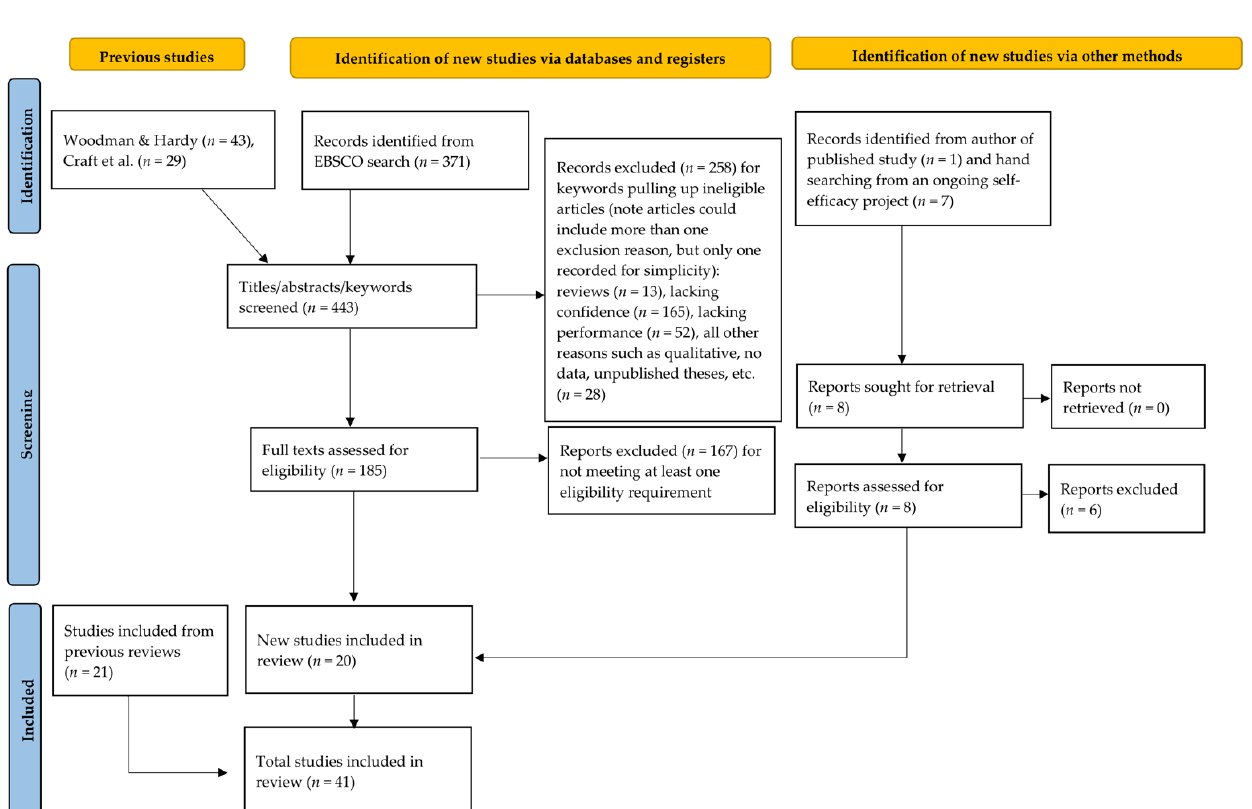
Figure 1. PRISMA flow chart for the identification of the included studies.